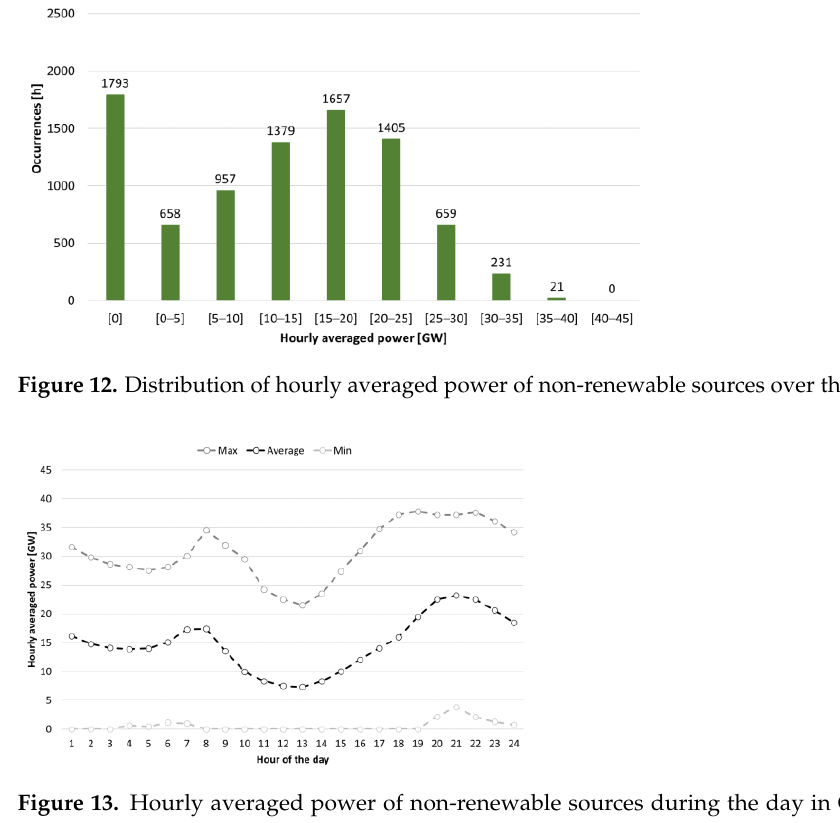
Figure 13. Hourly averaged power of non-renewable sources during the day in Case 2; average, maximum and minimum values.